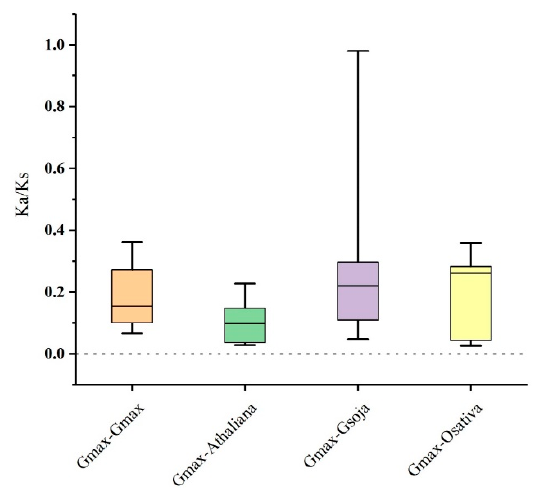
Figure 6. The ratio of nonsynonymous to synonymous substitutions (Ka/Ks) of SMXL genes in soybean and other three species. The species’ names with the prefixes’Gmax’, ‘Athaliana’, ‘Gsoja’ and ‘Osativa’ indicated Glycine max , Arabidopsis thaliana , Glycine soja and Oryz sativa , respectively.